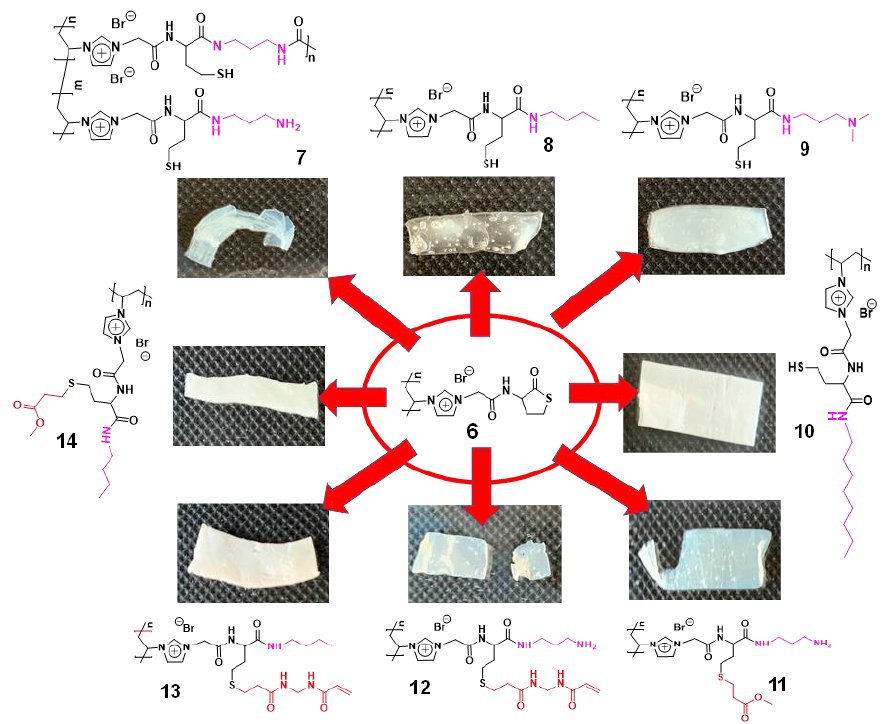
Figure 5. Post-modification of NFm- 6 using different reagents (amines and diamines). Pictures show the appearance of the mat after modification.